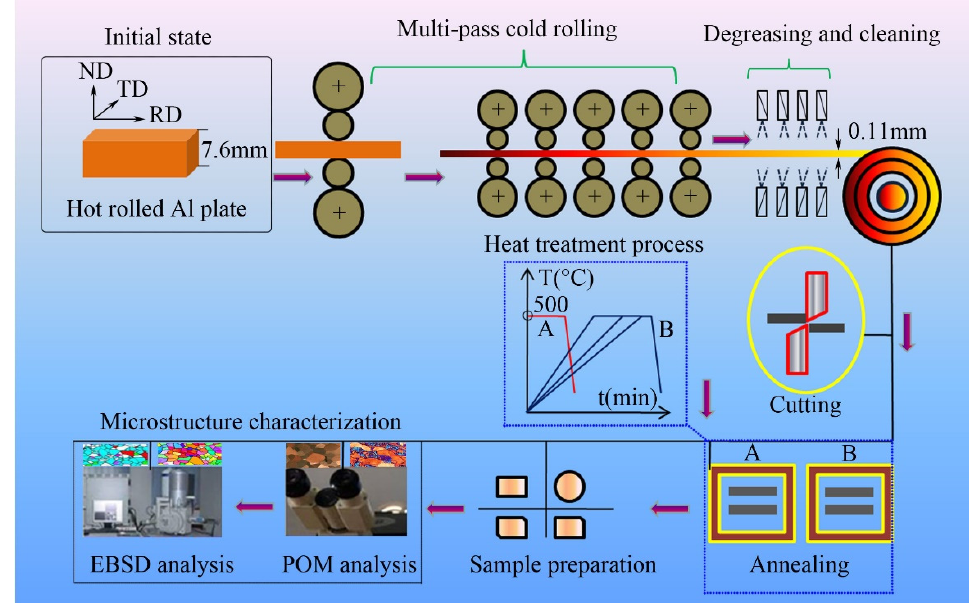
Figure 1. The schematic of processing route and sample characterization.